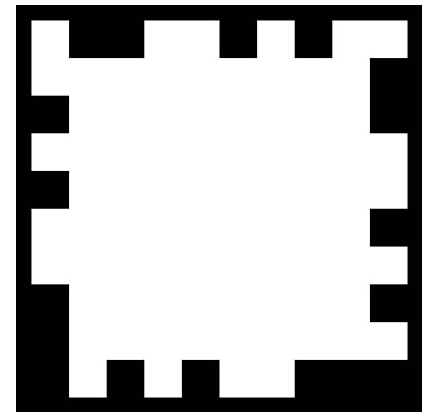
Fig. 5. Frame marker designed for the